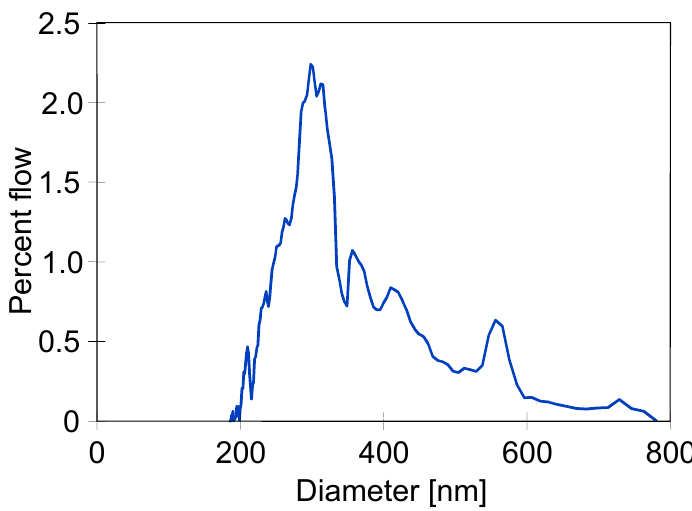
Table 2. Dimensions of capillary PTFE membranes used in the present study.